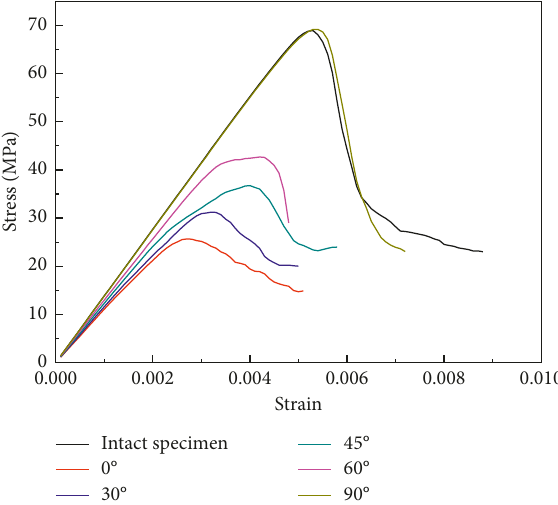
Figure 8: The damage conditions of different homogeneity index samples under peak stress status ( λ ). (a) λ (e) λ 7. (cid:30)